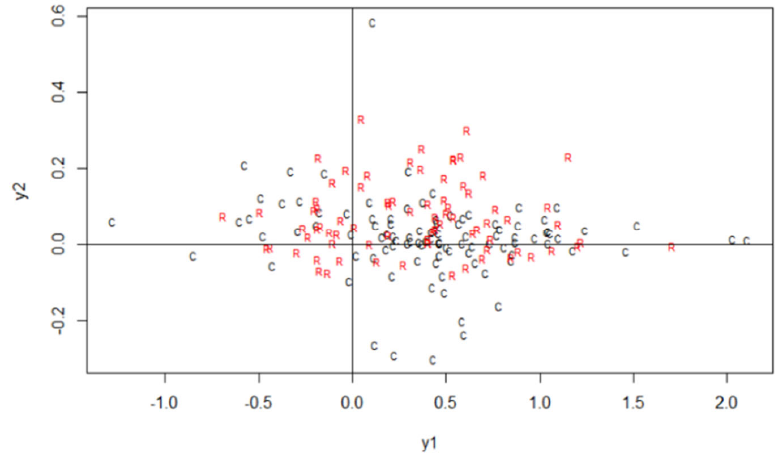
Fig. 4. Scatterplot of the compositional indicators y 1 and y 2 by region Notes: C indicates Catalonia and R La